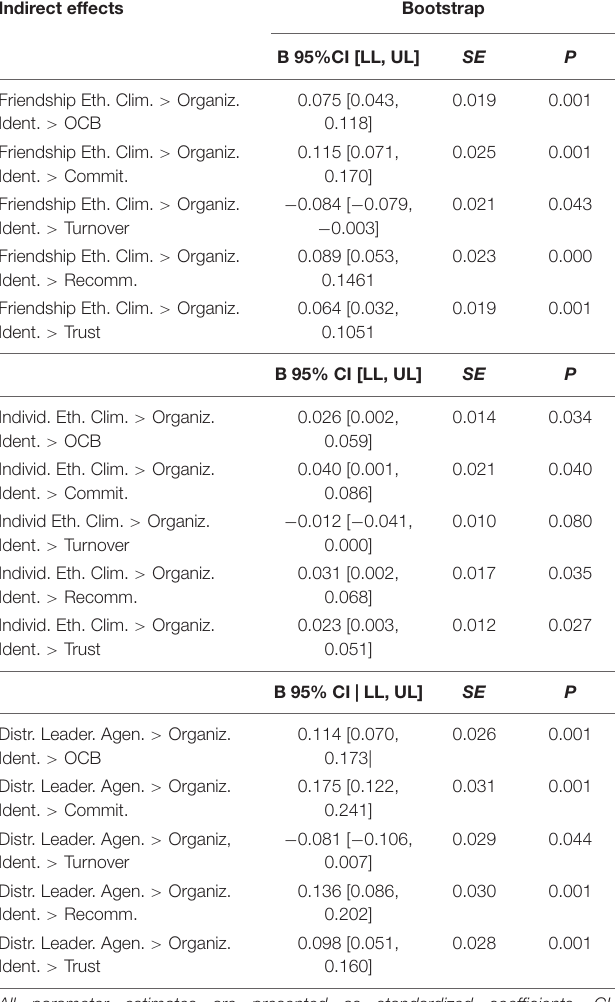
TABLE 3 | Indirect effects using bootstrapping (2,000 replications) in the tested model. Indirect